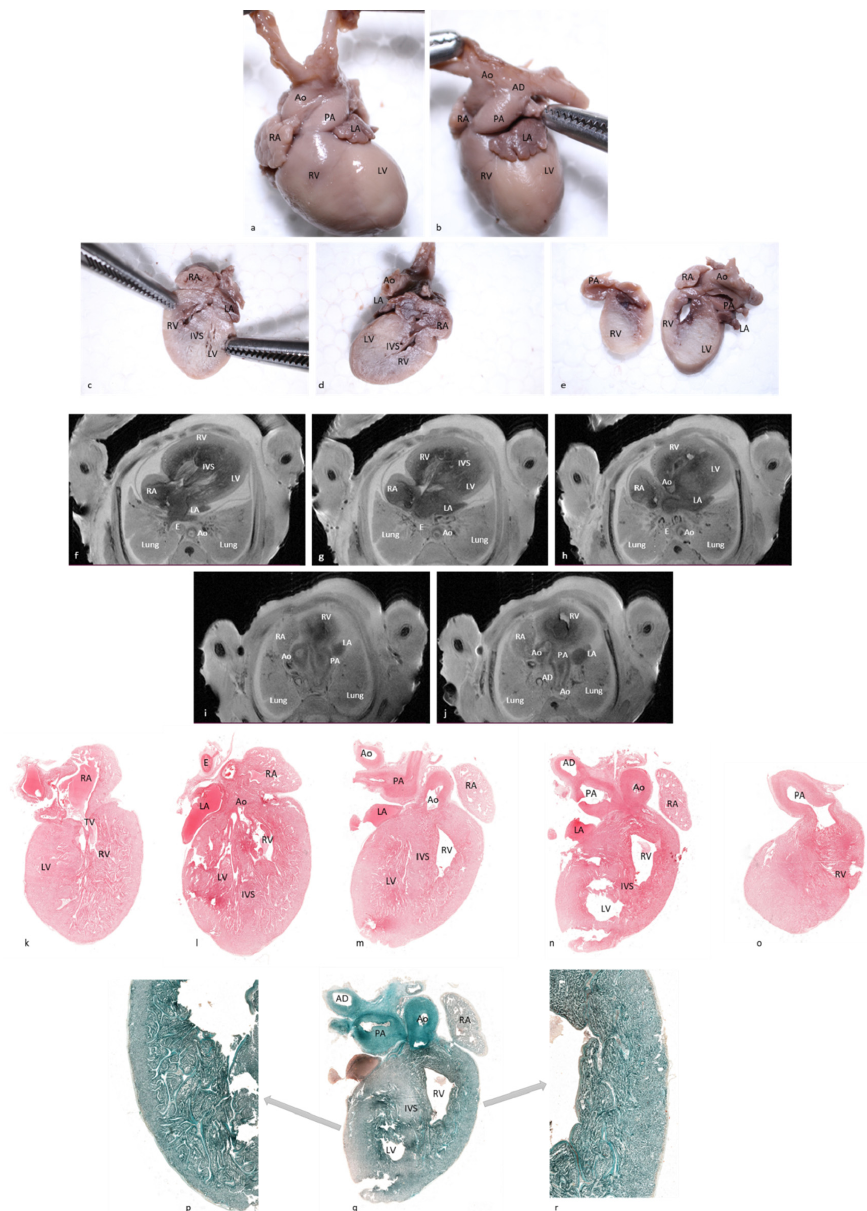
Figure 6. Comparative examination of pm-MRI at 7T (T2, WI) and four-chamber cardiac dissection of a 16-week gestation-age male with 18 Trisomy resulted from a therapeutic interruption of pregnancy (case 12 in the text). ( a , b ) Macroscopic anterior and antero-lateral view of the fetal heart. Thickening of great vessels and biventricular fibroelastosis. Thickened endocardium visible on pm-MRI images ( f , g , h , i , j ) but also on microscopic images (( p )—Masson’s trichrome stain, 1.4 × ; ( q )—Masson’s trichrome stain, 0.7 × ; and ( r )—Masson’s trichrome stain, 2.7 × ). Additionally, the thickening of great vessels, which can be observed on pm-MRI images, microscopy slides (( k )—hematoxylin-eosin stain, 0.6 × ; ( l )—hematoxylin-eosin stain, 0.6 × ; ( m )—hematoxylin-eosin stain, 0.5 × ; ( n )—hematoxylin- eosin stain, 0.7 × ; and ( o )—hematoxylin-eosin stain, 0.8 × ), and also on macroscopic sections ( c , d , e ). Abbreviations: RA—right atrium, RV—right ventricle, LA—left atrium, LV—left ventricle, Ao—aorta, PA—pulmonary artery, AD—arterial duct, IAS—interatrial septum, IVS—interventricular septum, IVC—inferior vena cava, SVC—superior vena cava, RPA—right pulmonary artery, RPV—right pul- monary veins, LPA—left pulmonary artery, TV—tricuspid valve, MV—mitral valve, I—infundibulum, E—esophagus, and